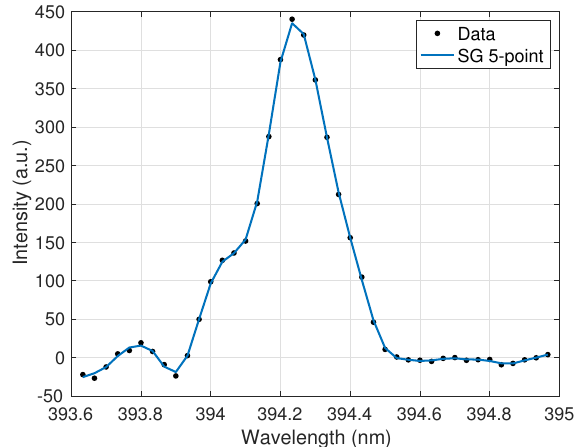
Figure 2. Ce II 394.3-nm emission peak after effective smoothing and noise reduction by a five-point Savitzky–Golay (SG)